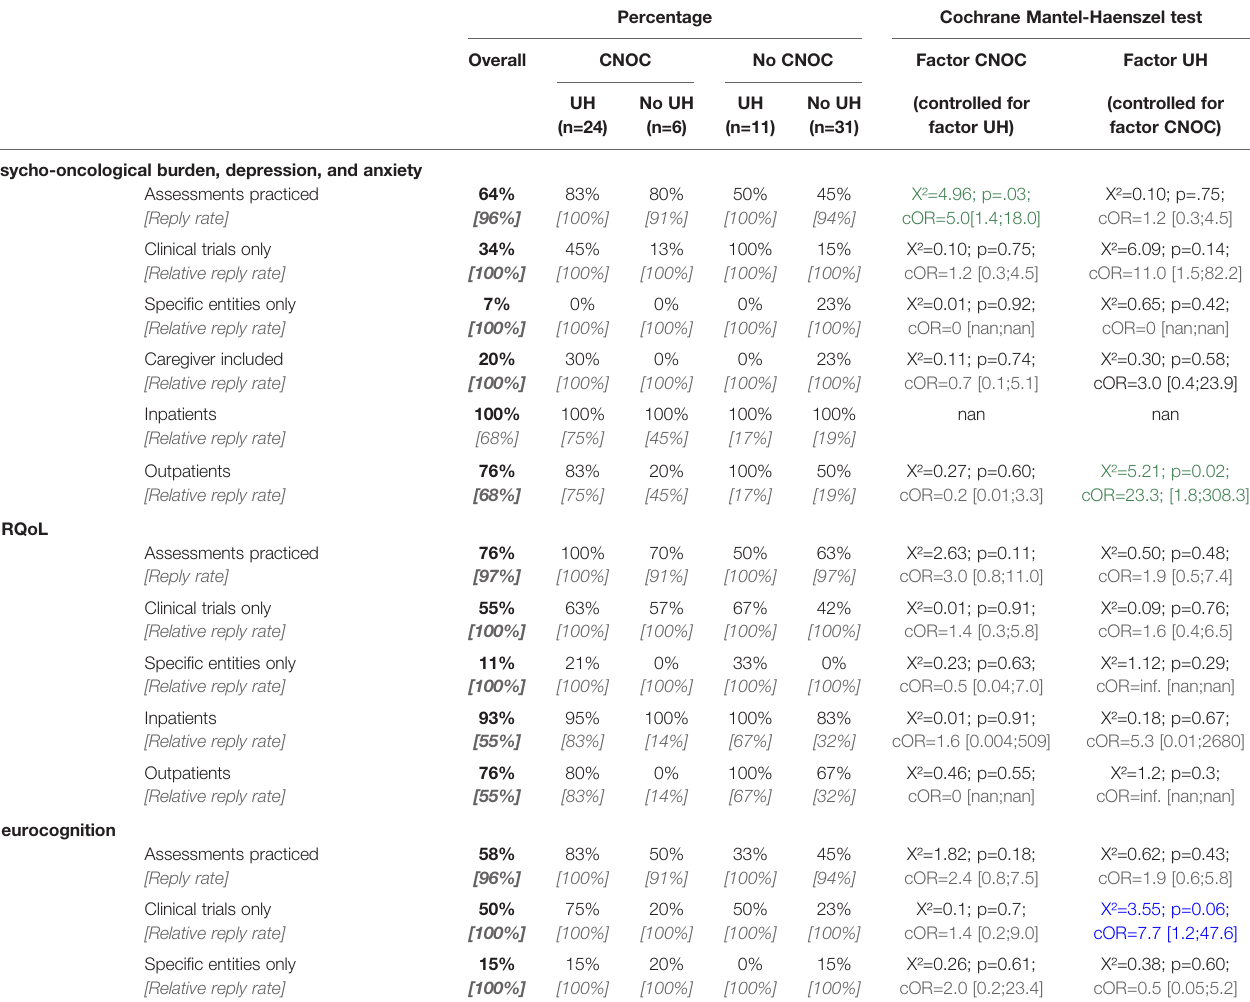
TABLE 3 | Regularity and indications of PRO and neurocognitive